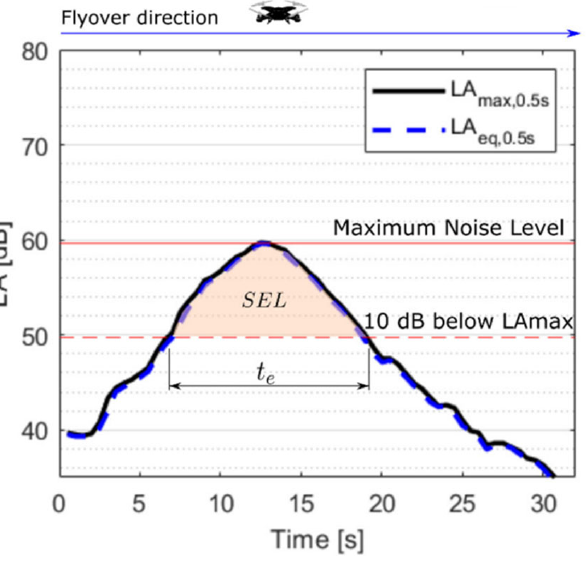
Figure 5. Sound exposure level 𝑆𝐸𝐿 , maximum noise level 𝐿𝐴 (cid:3040)(cid:3028)(cid:3051) , and effective time 𝑡 (cid:3032) . The pre ‐ sented data corresponds to a recording during a fast flyover operation of the drone